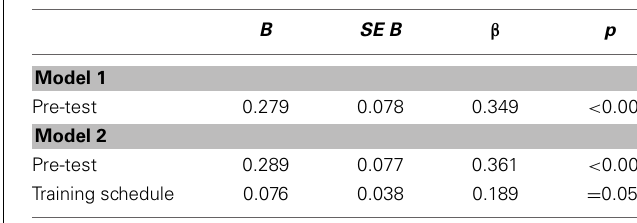
Table 4 | Regression analysis showing the effect of training schedule on SPM post-test.